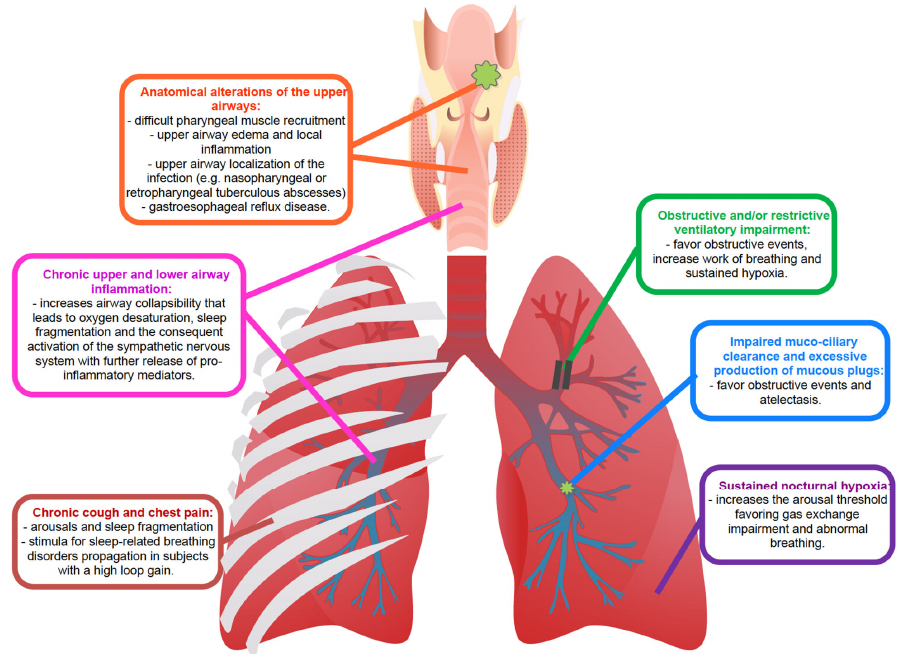
Figure 2. Summary of the main pathophysiological mechanisms causing SDB in chronic respiratory